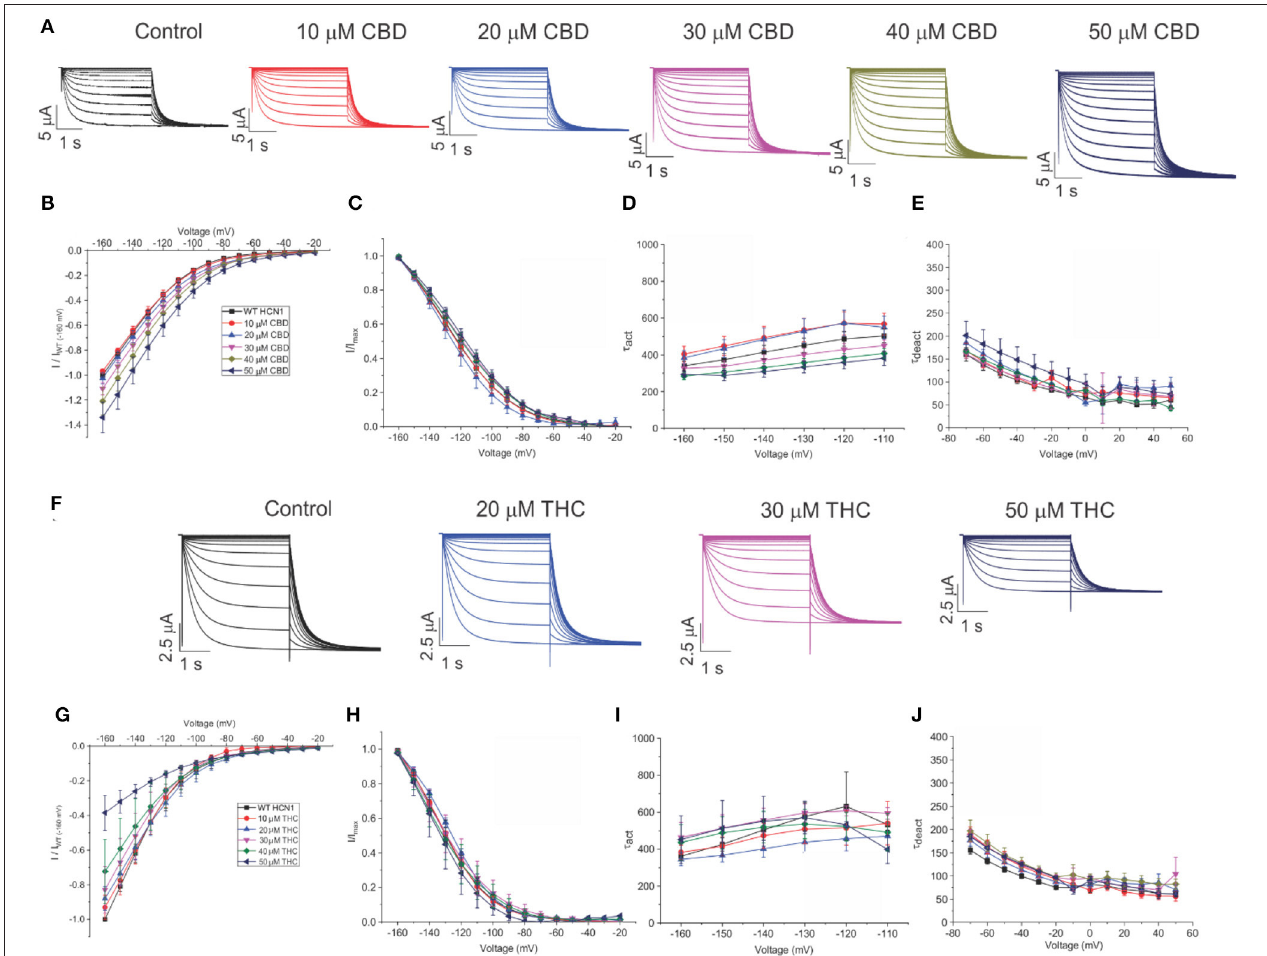
FIGURE 3 | Regulation of HCN1 by cannabidiol (CBD) and 1 9 -tetrahydrocannabidiol (THC). (A) Representative traces from a paired experiment following the addition of increasing concentrations of CBD to oocytes expressing full-length HCN1. (B) Current–voltage (I/V) relationship in presence of CBD normalized to maximal current (I WT( − 160mV) ) (5 < n < 18 per condition; P < 0.05 for 30–50 µ M). (C) Steady state activation in presence of CBD ( P = 0.81 for V 1 / 2 ). (D) Activation time constant ( τ ) kinetics in presence of CBD (0.21 < P < 0.71). (E) Deactivation time constant ( τ ) kinetics in presence of CBD (3 < n < 7 per condition; 0.09 < P < 0.65). (F) Representative traces from a paired experiment following the addition of increasing concentrations of THC to oocytes expressing full-length HCN1. (G) (I/V) relationship in presence of THC normalized to maximal current (I WT( − 160mV) ) (4 < n < 8 per condition; P < 0.05 for Gmax (slope between − 120 and − 160mV)